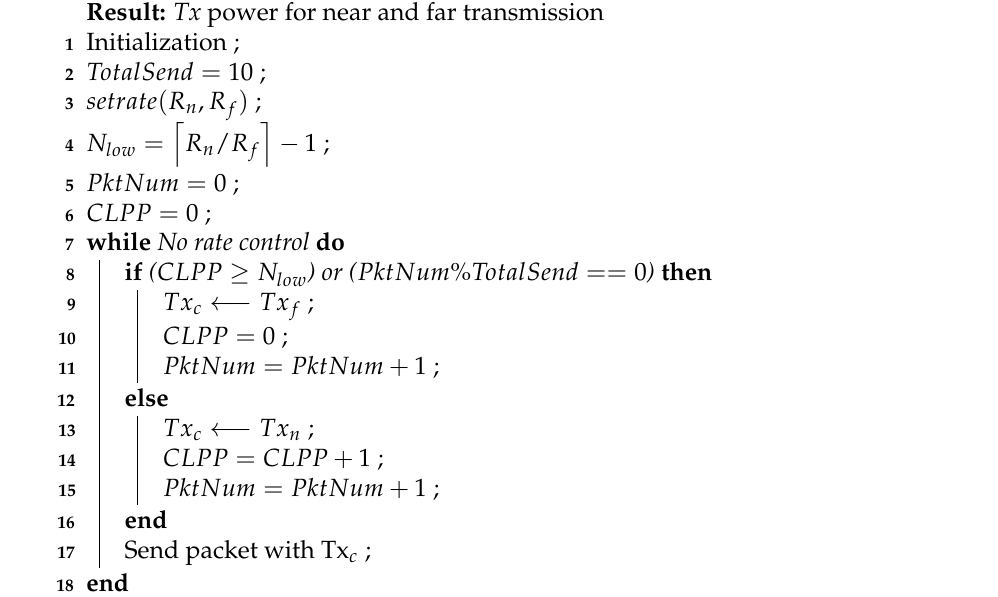
Algorithm 1: Balancing awareness and congestion with variable Tx